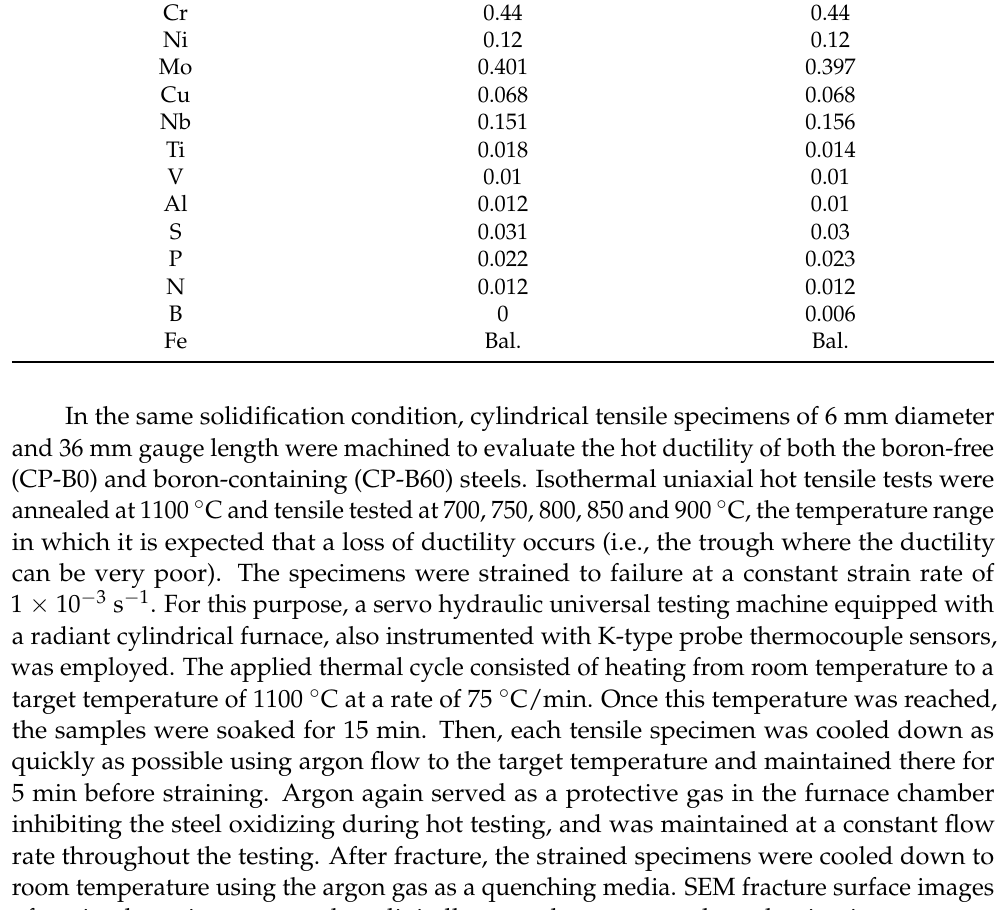
Table 1. Chemical composition of the experimental advanced high strength complex phase (CP) steels (in wt.%). Element CP-B0 Steel CP-B60 Steel C